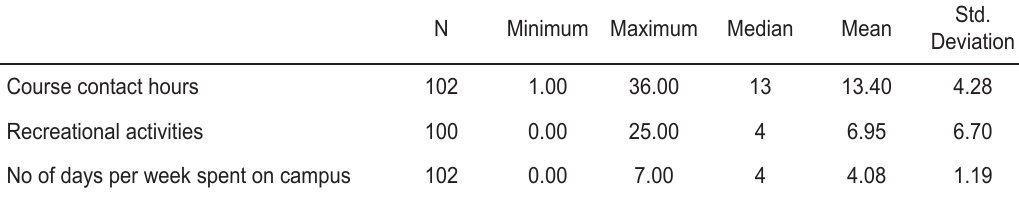
Table 3: Average time spent per week at University The mean number of hours using the campus for recreational purposes was 6.95 (SD 6.7 hours) and the median was 4 hours.